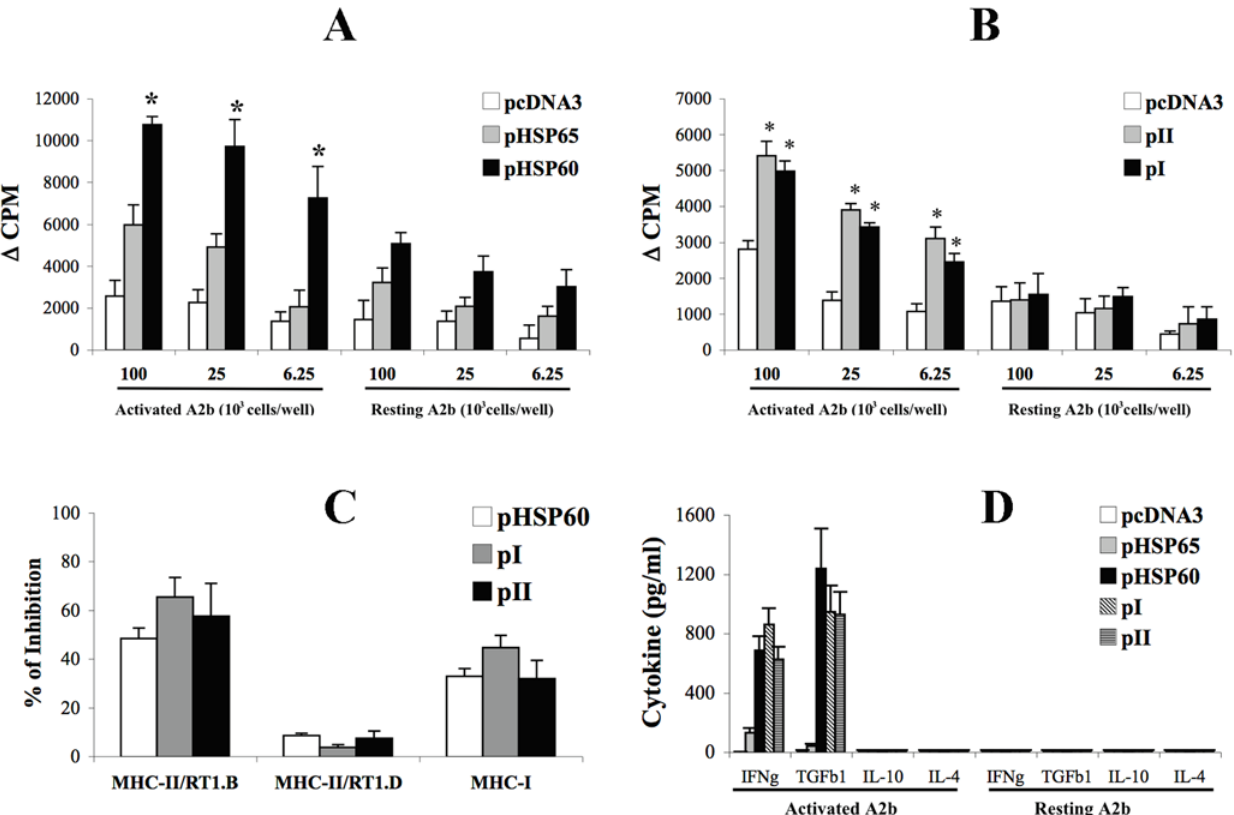
Figure 1. DNA vaccination with HSP60 induces anti-ergotypic T cells. A and B. Anti-ergotypic proliferative response of LNC from rats vaccinated with pcDNA3, pHSP65 or pHSP60 (A) or pcDNA3, pI or pII (B), taken 26 days after the induction of AA. Proliferative responses are presented as the D CPM 6 SEM of quadruplicate cultures. * p , 0.05 compared to the pHSP65 (A) or the pcDNA3 (B) groups. C. Monoclonal antibodies to MHC-II/RT1.B, MHC-II/RT1.D or MHC-I were assayed for their ability to block the anti-ergotypic proliferative response. Results are presented as the percent of inhibition of proliferation 6 SEM of quadriplicate cultures. D. Anti-ergotypic cytokine response of LNC taken from rats vaccinated with pcDNA3, pHSP65, pHSP60, pI or pII 26 days after the induction of AA. IFN c (IFNg), TGF b 1 (TGFb1), IL-10 and IL-4 were quantified in the culture supernatants after 72 hr of stimulation with 10 5 activated or resting, irradiated, A2b cells per well. The results are presented as pg/ml 6 SEM of triplicate cultures. Three independent experiments produced similar